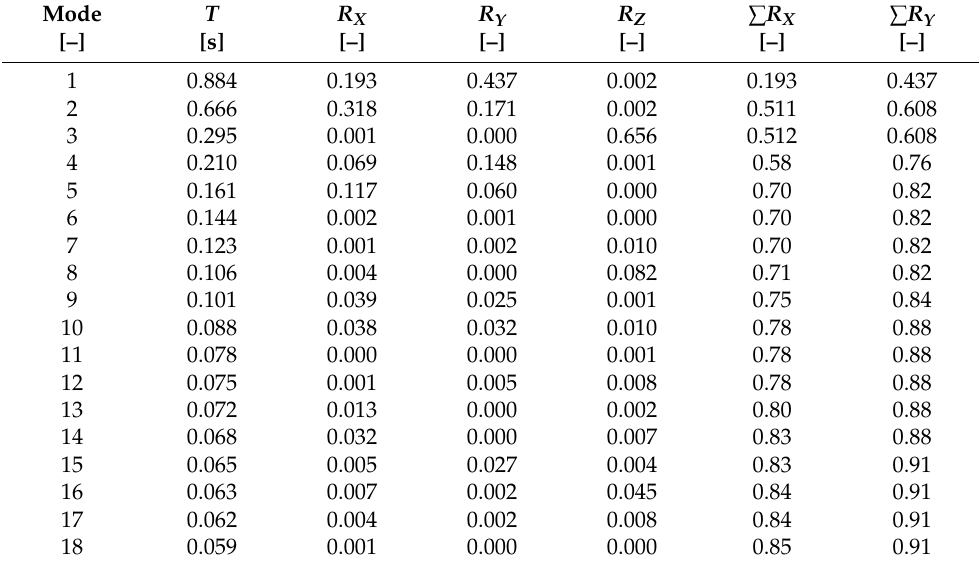
Figure 14. Third vibration mode shape of the tower (T = 0.295 s): ( a ) 3D view; ( b ) top view; ( c ) front view. Table 1. Modal properties.